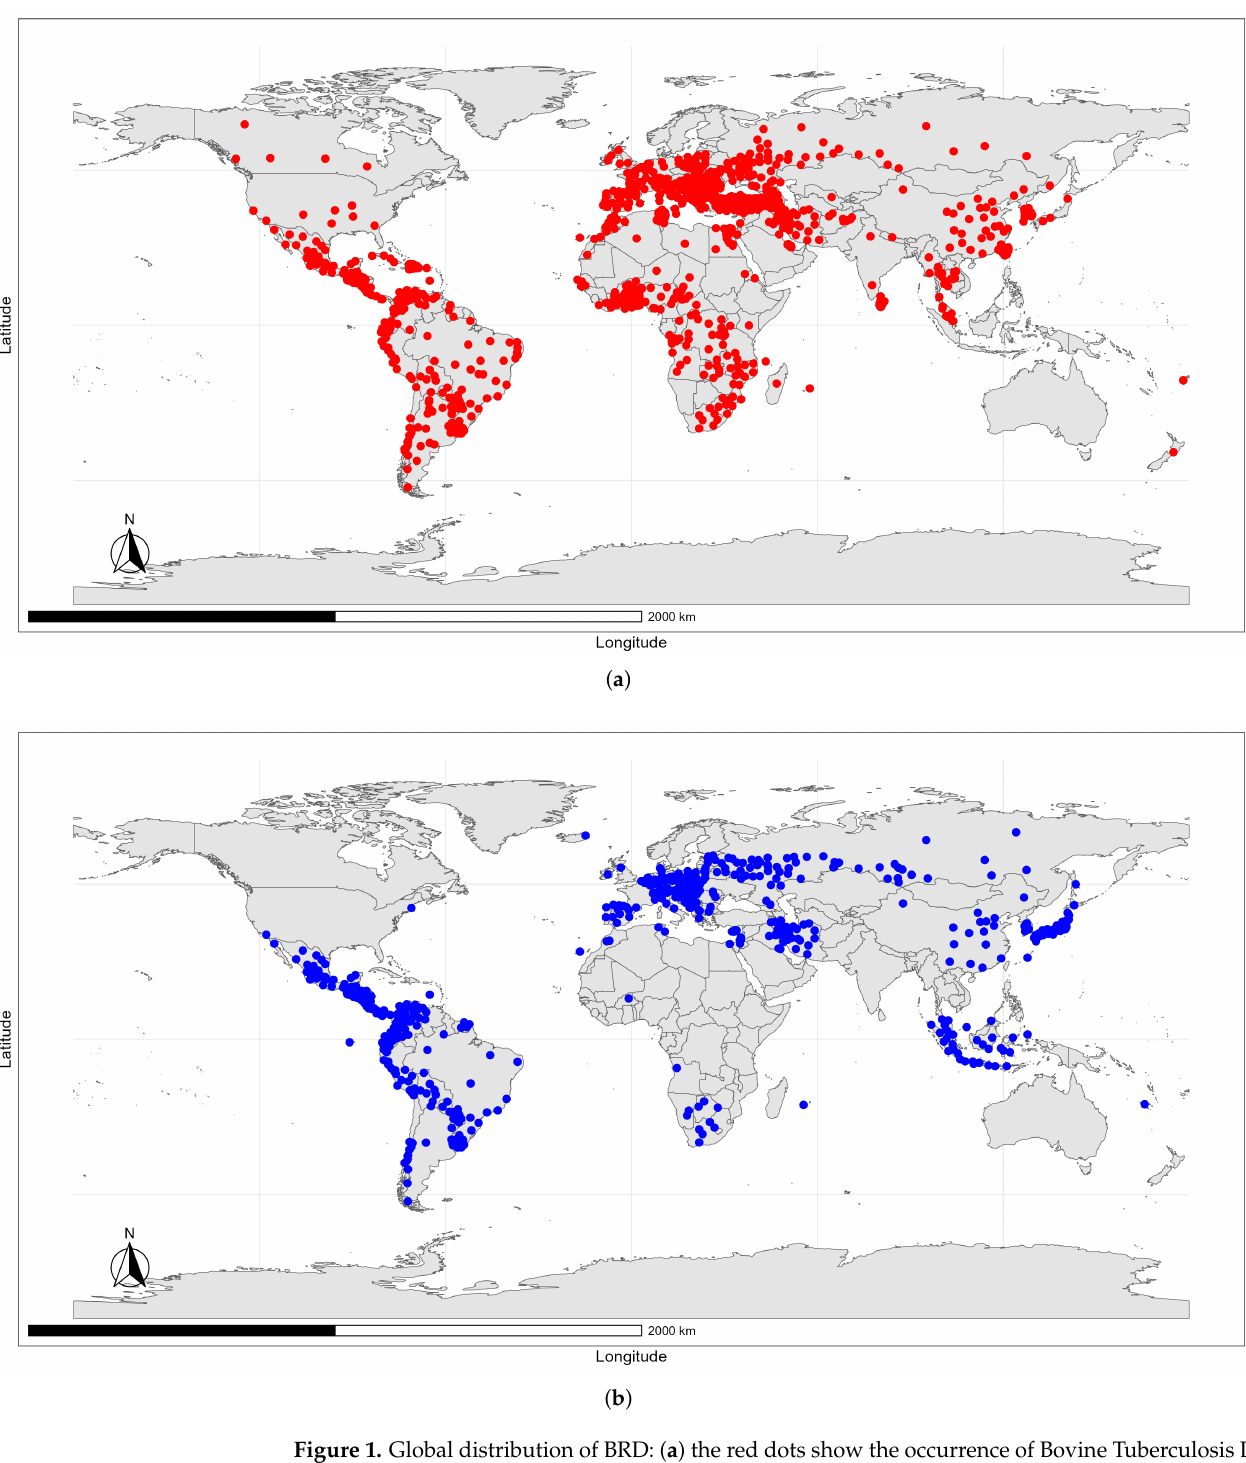
Figure 1. Global distribution of BRD: ( a ) the red dots show the occurrence of Bovine Tuberculosis Dis- ease (BTD) and ( b ) the blue dots represent the occurrence of Infectious Bovine Rhinotracheitis